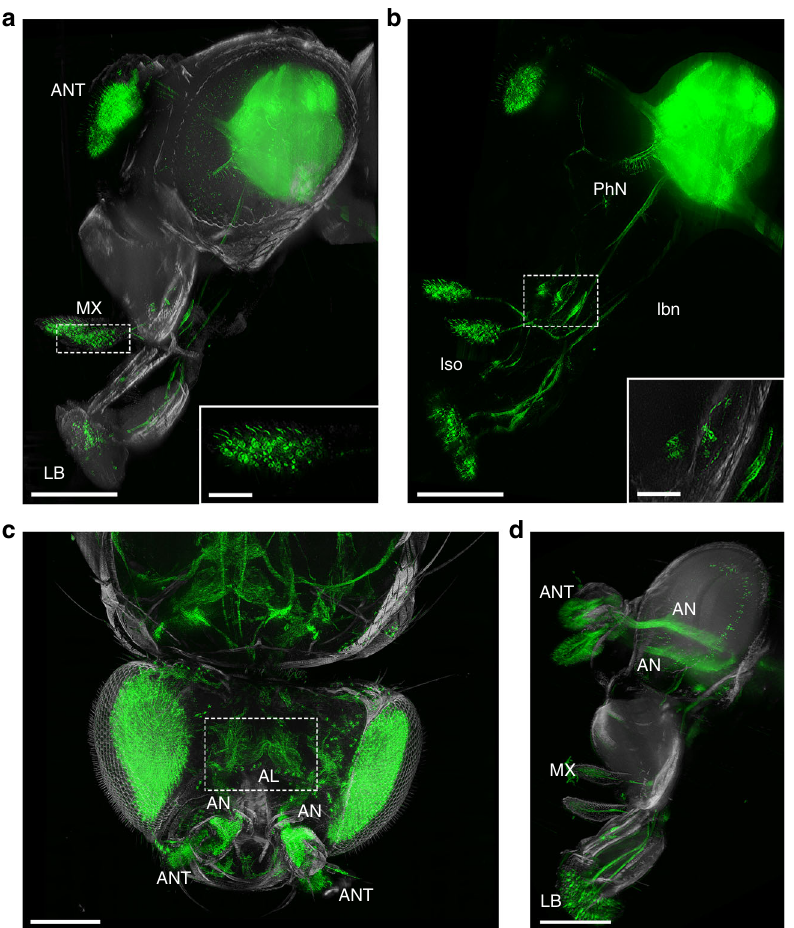
Fig. 5 Imaging of the Drosophila chemosensory system of a FlyClear treated intact adult fl y using optimised aspheric ultramicroscope. a – d Light-sheet images of GFP expression in sensory neurons. a Lateral view of olfactory and gustatory receptor neurons in antenna (ANT), maxillary palp (MX) and labellum (LB). The inset shows a higher magni fi cation of the maxillary palp. b Pharynx and the connection of the pharyngeal nerve (PhN) with the ventral cibarial sense organ (vcso), the labral sense organ (lso), and the connection of the labellum with the labial nerve (lbn). The inset shows a higher magni fi cation of the vcso with single neurons. c Dorsal view of antennal receptor neurons, which are connected with the antennal lobe (AL) (dashed box) through the antennal nerve (AN). d Lateral view of the connection described in c . Images in a – c were acquired with a 10x water-immersion objective (Olympus, UMPlanFLN, 0.3 NA, WD = 3.5 mm) with custom-made correction of optics for a refractive index of 1.45 (WD = 3.5 mm after correction). In a , b a post-magni fi cation of 2x was used. Image in d was acquired with a 0.5x post-demagni fi cation in combination with a 25x objective (Olympus, XLPlanN, 1.0 NA, WD = 8 mm). Genotype: a , b dscam-Gal4/CyO; UAS-mCD8::GFP and ( c – e ) Peb-Gal4 UAS-mCD8::GFP . Scale bars represent 200 µ m